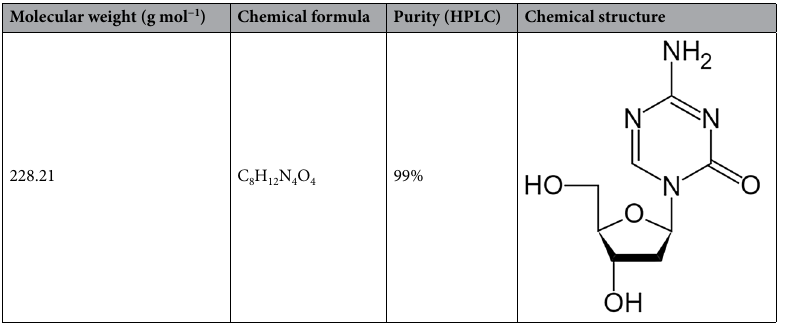
Table 1. Properties of